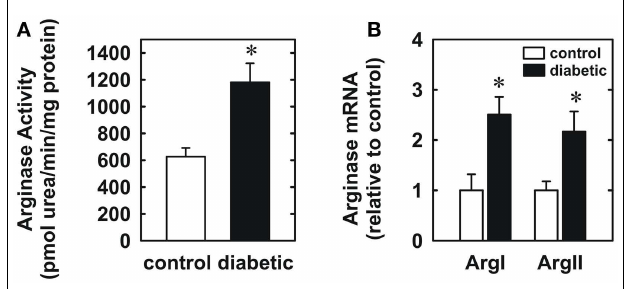
FIGURE 1 | Diabetes stimulates vascular arginase activity and expression in rats . Diabetes increases arginase activity in the aorta (A) and arginase I and II mRNA expression in gracilis muscle arterioles (B) . Results are expressed as mean ± SEM ( n = 4–5). * Statistically significant effect of diabetes ( p <